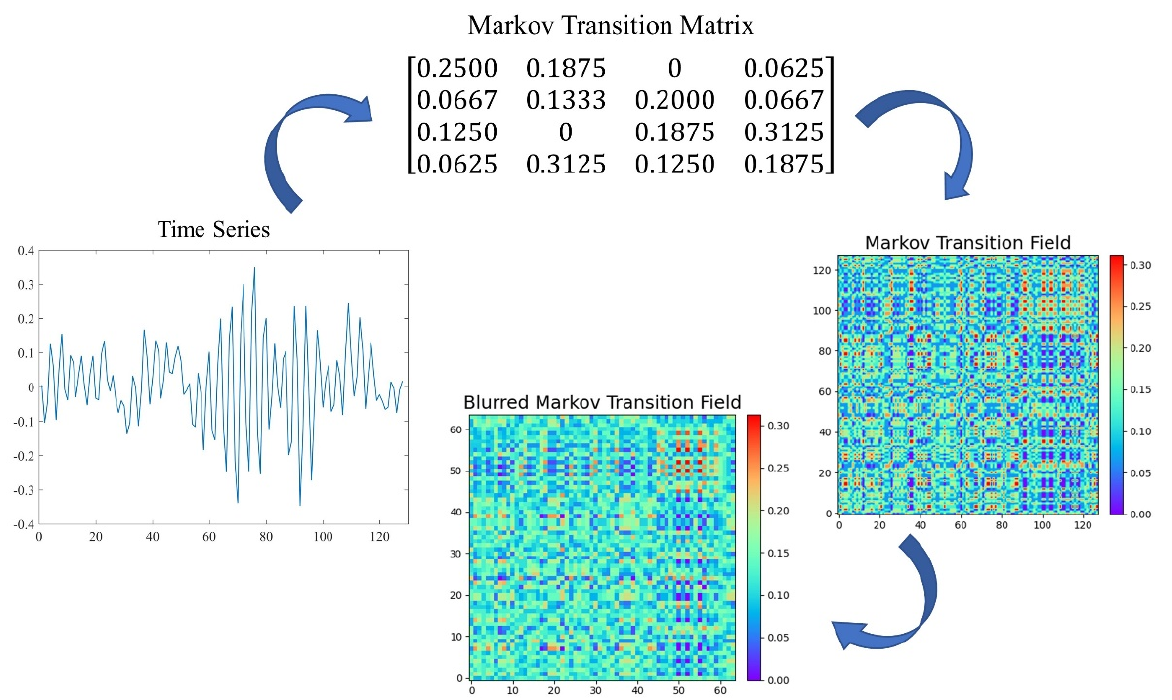
Figure 3. Transformation process of Markov transition field.